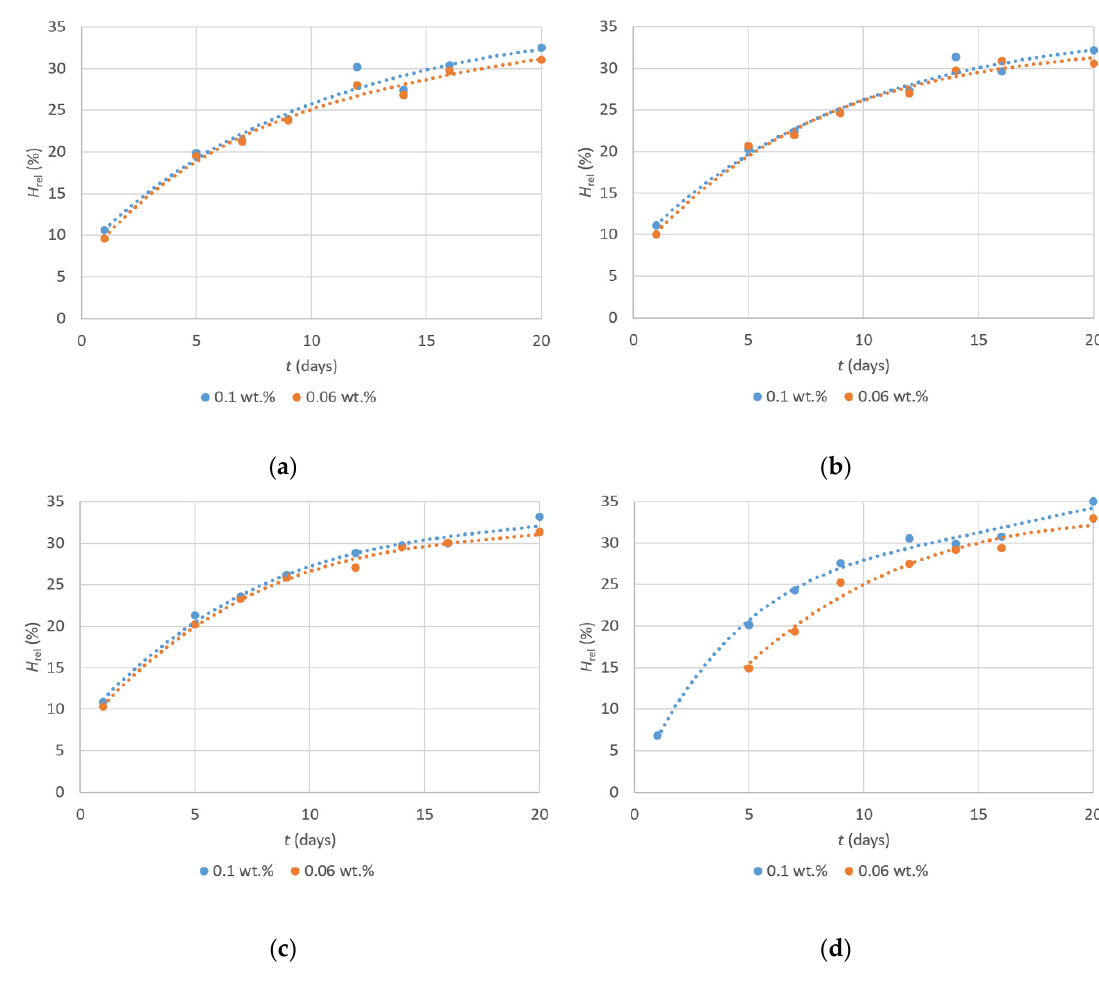
Figure 3. Effect of concentration on development of the relative hardness of test coatings cured by compounds 1 ( a ), 2 ( b ), 3 ( c ) and 4 ( d ).